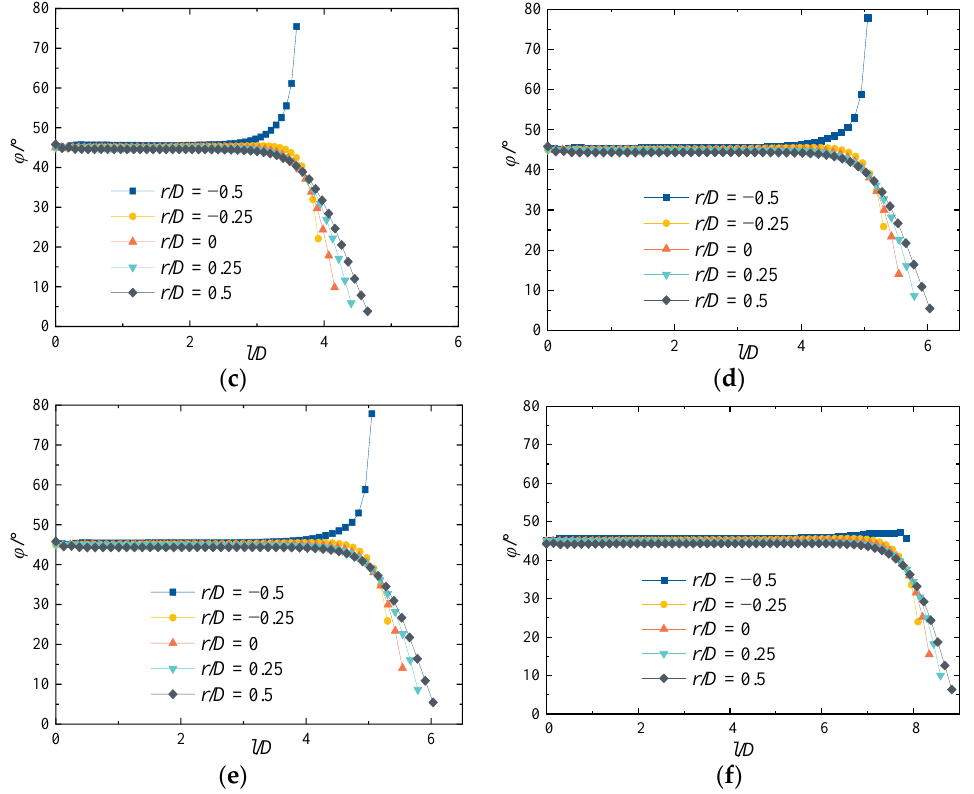
Figure 10. Development of flow angle φ along the axial direction at different radial locations under various impinging heights: ( a ) H/D = 1; ( b ) H/D = 2; ( c ) H/D = 3; ( d ) H/D = 4; ( e ) H/D = 6; ( f ) H/D = 8.